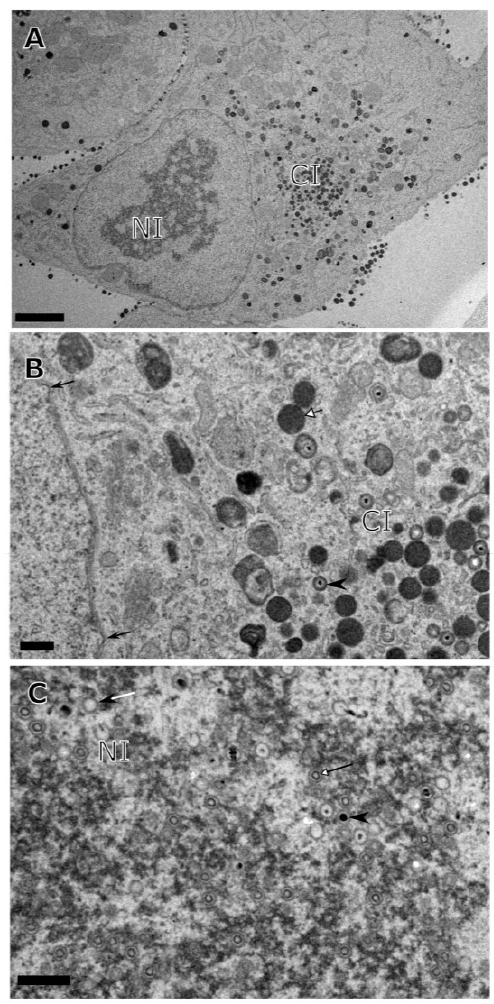
Figure 2. Transmission electron micrograph of HF cells infected with HCMV (Towne) and fixed for processing at 7 days post infection. ( A ) A single infected cell showing nuclear inclusion (NI), as well as cytoplasmic inclusion (CI); ( B ) Interface of nucleus and cytoplasm illustrating nuclear budding events (black arrows), mature virions (arrowheads) and dense bodies (open head arrows); ( C ) Infected cell nucleus showing the distribution of A- (white tailed arrows), B- (black tailed arrows) and C- capsids (arrowheads). Scale: 4 µm ( A ), 0.5 µm ( B ), 0.4 µm ( C